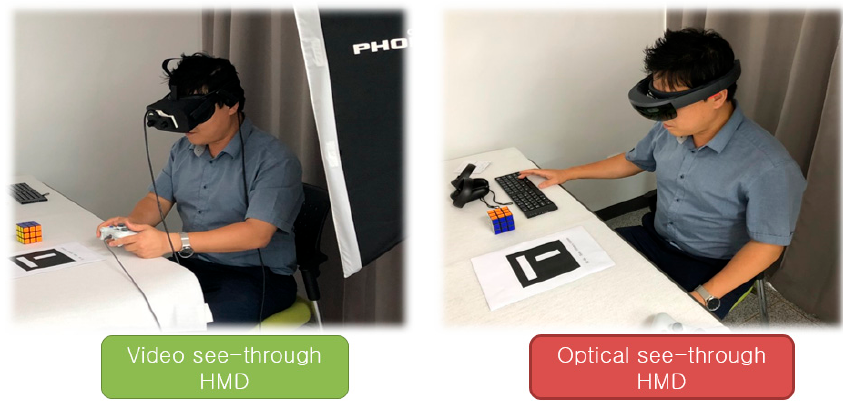
Figure 5. Video see-through HMD with a dual webcam module attached, which allowed the user to visualize the virtual cube ( left ), and the optical see-through HMD, which allowed the user to integrate the virtual cube into reality since the device was semi-transparent in our experiment ( right ). Participants could see the virtual cubes placed on the fiducial MR marker. In the experiment, the keyboard (in the right image) was used for the initial start, and the joystick (in the left image) was used for the actual experiment.